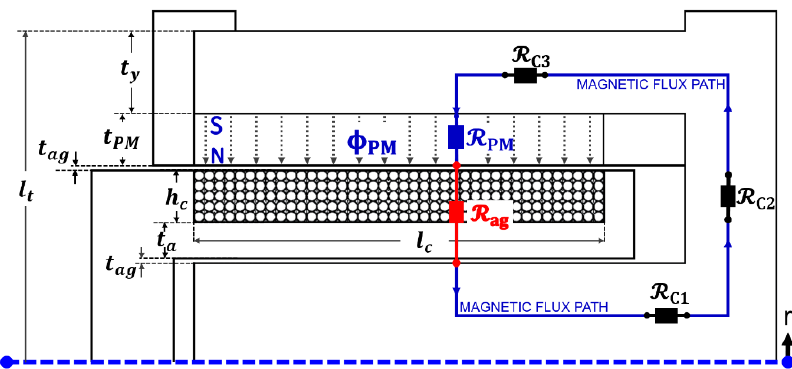
Figure 3. Lumped-circuit element based magnetic circuit model of the VCM, where 𝑡 (cid:3017)(cid:3014) , 𝑡 (cid:3028)(cid:3034) , 𝑡 (cid:3028) , and 𝑡 (cid:3052) are the thickness of the permanent magnet (PM), air-gap, armature, and yoke, respectively. 𝑙 (cid:3047) is the length from the outer face to the axis of the VCM. ℛ (cid:2913)(cid:2869) , ℛ (cid:2913)(cid:2870) , and ℛ (cid:2913)(cid:2871) are the equivalent reluctance of the stator material.